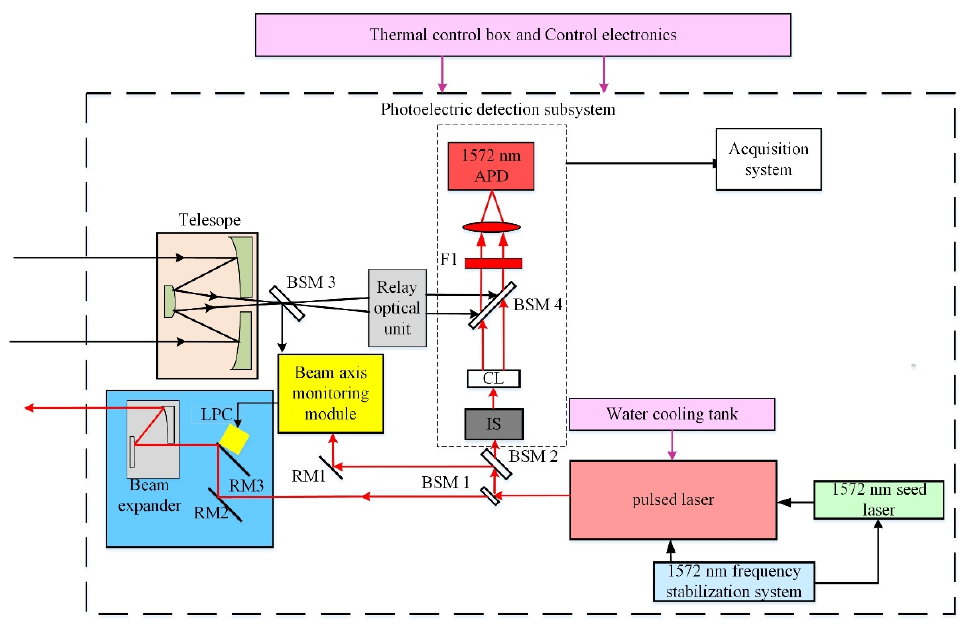
Figure 1. Schematic diagram of the spaceborne IPDA LIDAR system. BSM1, 2, 3, 4: beam splitter mirrors; RM 1, 2 and 3: reflecting mirrors; IS: integrating sphere; CL: collimating lens; LPC: laser pointing control; F1: filter; APD: Avalanche photodiode. Table 1. System parameters of the spaceborne IPDA LIDAR.